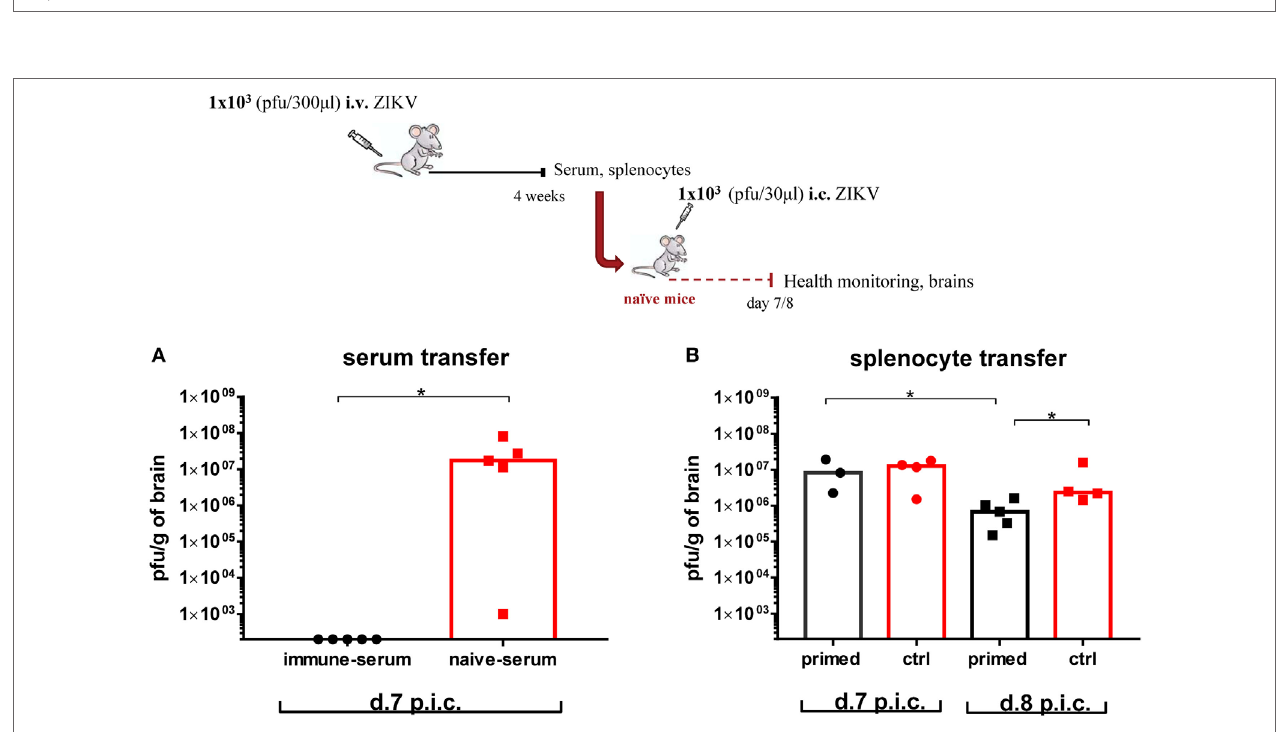
FigUre 9 | Immune serum transfer confers full protection against Zika virus (ZIKV), while primed splenocytes are marginally effective. Wild-type C57BL/6 mice were inoculated with 1 × 10 3 pfu ZIKV i.v., and 4 weeks later, serum and splenocytes were harvested for adoptive transfer to naïve recipients. (a) Naïve mice received the immune serum 3 and 1 days prior to i.c. challenge with 1 × 10 3 pfu ZIKV. On day 7 post i.c. challenge, brains were removed and viral titers were measured by a plaque assay. (B) Naïve mice received primed splenocytes 2 days prior to i.c. challenge with 1 × 10 3 pfu ZIKV. Mice were weighed and monitored daily and on days 7 and 8 post i.c. challenge, brains were removed and viral titers were measured by a plaque assay. Groups of naïve mice, receiving serum or splenocytes (PBS) from naïve donors were included as negative controls. The detection limit for virus in the brain was 250 pfu/g organ. Each dot represents an individual animal, and bars represent the medians of the groups. n = 3–5 mice/group,* p <